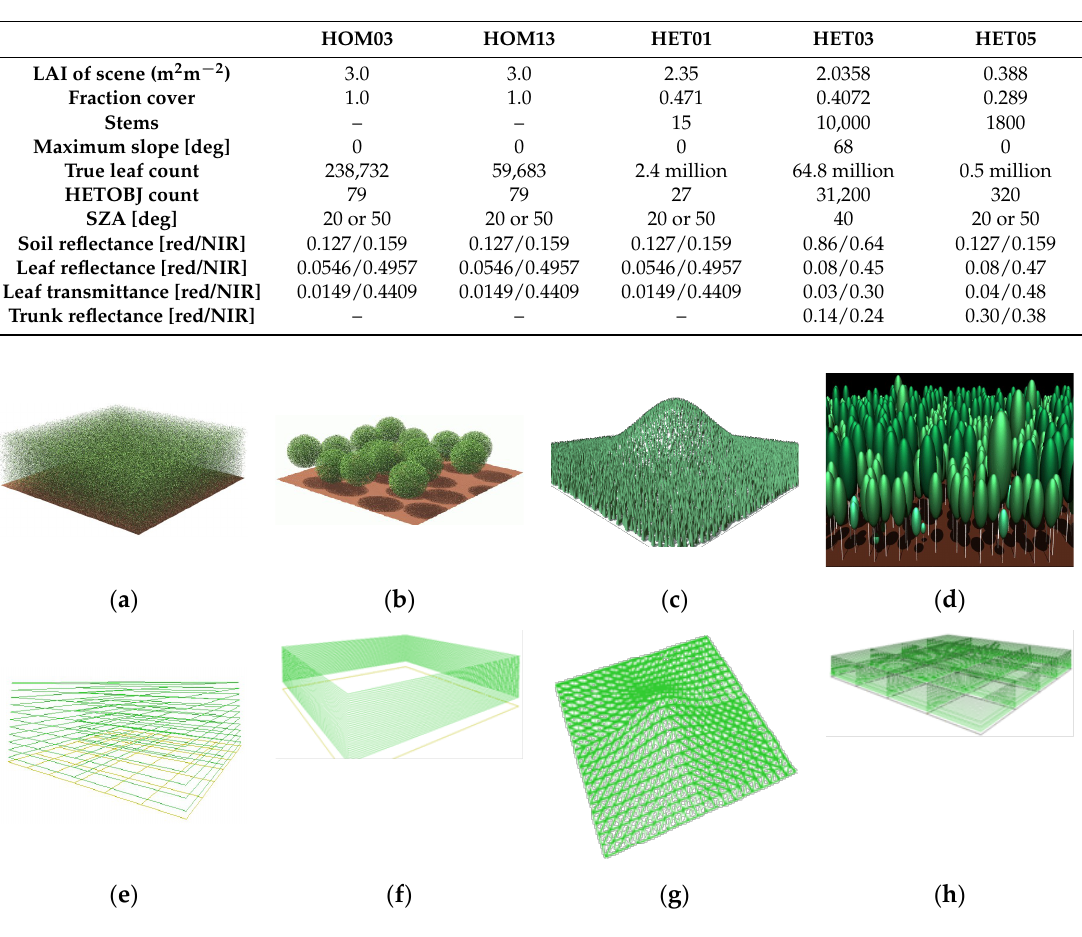
Figure 7. Test scenes from RAMI-3: ( a ) homogeneous canopy (HOM03/13); ( b ) discrete trees (HET01); ( c ) pine forest on a Gaussian surface (HET03); ( d ) birch forest (HET05); ( e ) HOM03/13 using HETOBJ; ( f ) HET01 using HETOBJ; ( g ) HET03 using HETOBJ; ( h ) HET05 using